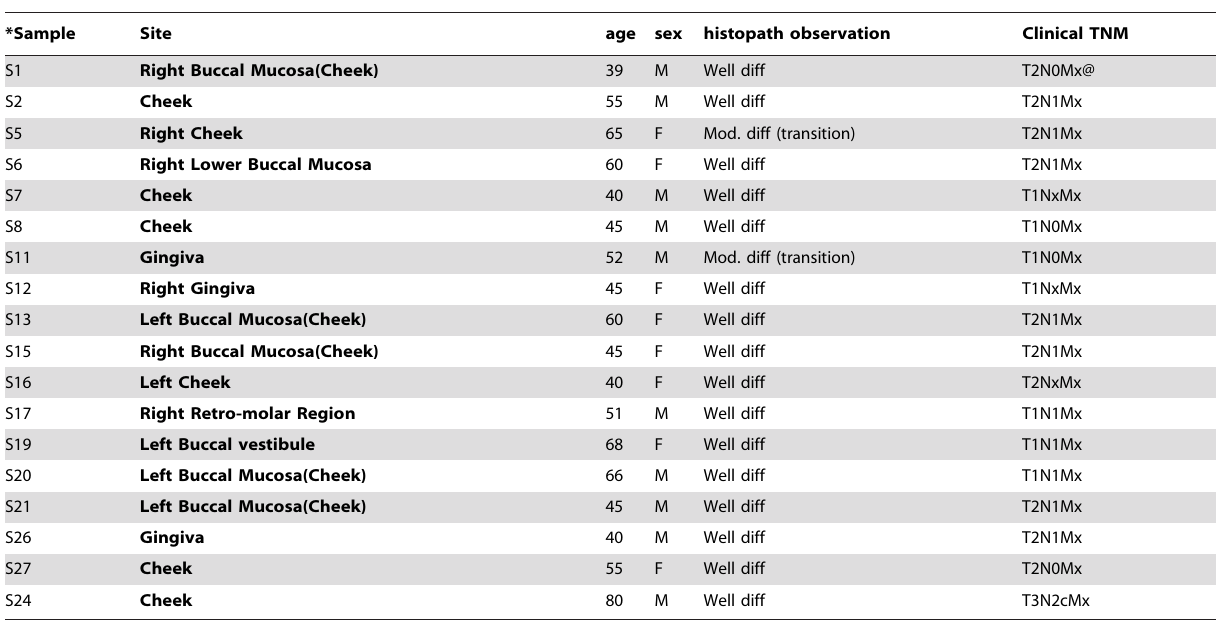
Table 1. Demography of 18 cancer patients and their tumor differentiation